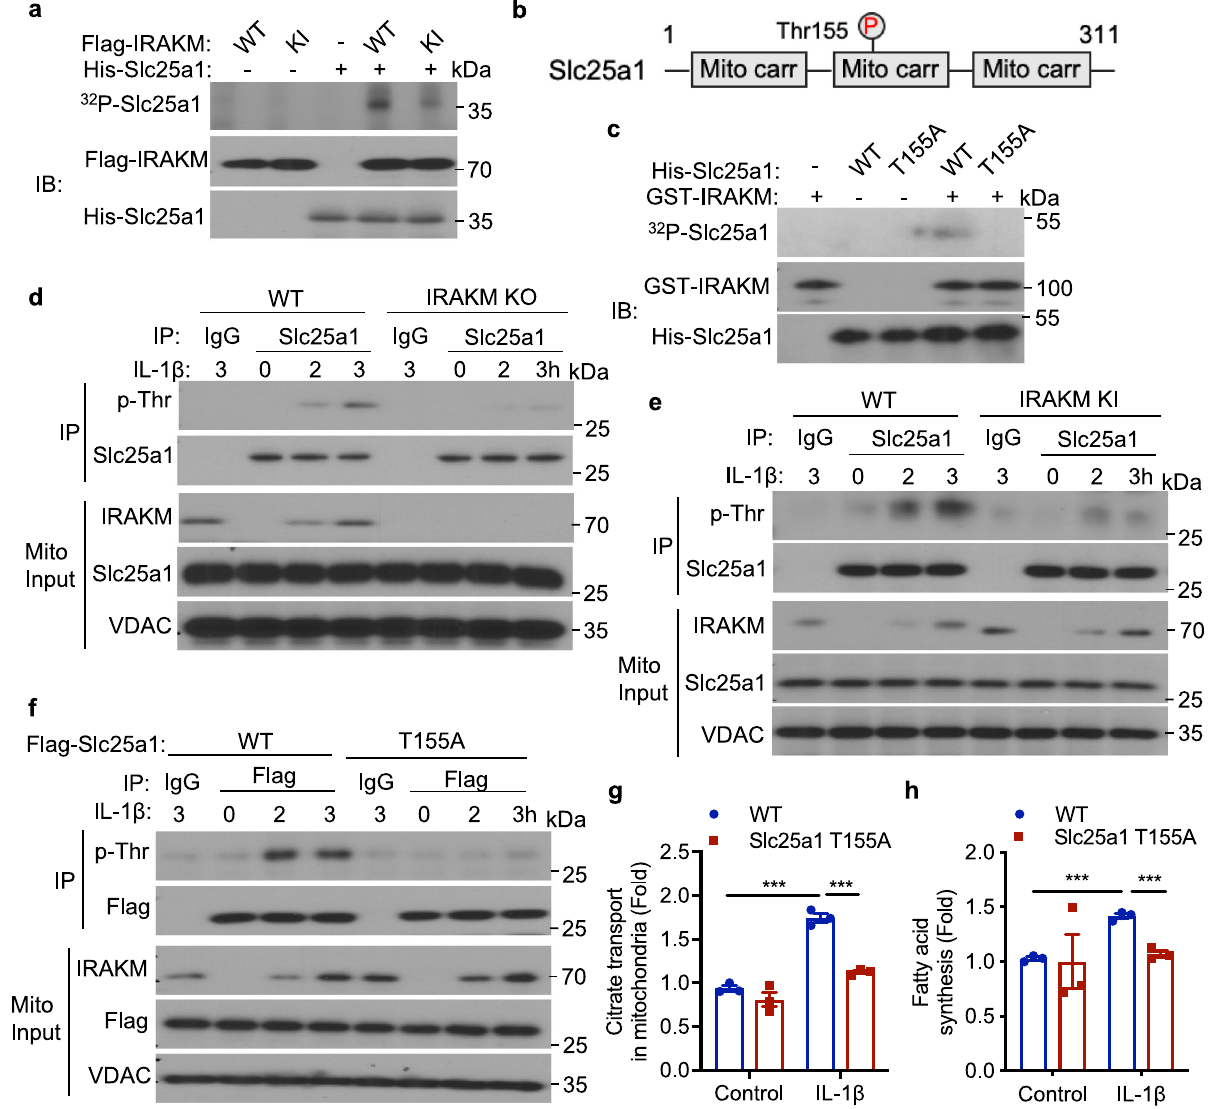
Fig. 5 IRAKM as a unique kinase phosphorylates Slc25a1 to regulate mitochondrial citrate transport. a In vitro kinase assay of recombinant His-tagged Slc25a1 with Flag-tagged IRAKM WT and kinase-inactive (KI) mutant protein. Data are representative of three independent experiments. b Scheme of Slc25a1 protein. Threonine 155 residue was identi fi ed to be phosphorylated by IRAKM. c In vitro kinase assay of recombinant GST-tagged IRAKM protein with His-tagged Slc25a1 WT and Thr155 non-phosphorylated mutant (T155A). Data are representative of three independent experiments. d Co- immunoprecipitation (IP) analysis was performed with anti-Slc25a1 antibody in mitochondrial lysate of IL-1 β treated primary WT and IRAKM KO adipocytes and followed by western blot analysis for indicated proteins. Data are representative of three independent experiments. e Co-IP analysis was performed with anti-Slc25a1 antibody in mitochondrial lysate of IL-1 β treated primary WT and IRAKM KI adipocytes and followed by western blot analysis for indicated proteins. Data are representative of three independent experiments. f – h Flag-tagged wild-type and Slc25a1 T155A mutant were restored in Slc25a1 KD primary adipocytes. f Co-IP analysis was performed with anti-Flag antibody in mitochondrial lysate of IL-1 β treated primary adipocytes and followed by western blot analysis for indicated proteins. Data are representative of three independent experiments. g Uptake rate of 14 C-Citrate was measured in intact mitochondria isolated from IL-1 β treated primary adipocytes ( n = 3; from left to right: P = 0.0002, 0.0003). h De novo fatty acid synthesis measured by the conversion of 14 C-glucose to lipids in primary adipocytes treated with or without IL-1 β for 24 h ( n = 3; from left to right: P = 0.0002, 0.0007). Statistical signi fi cance was determined by two-tailed Student ’ s t -test ( g , h ). *** P < 0.001. All data represent mean ± s.e.m. Source data are provided as the Source data fi